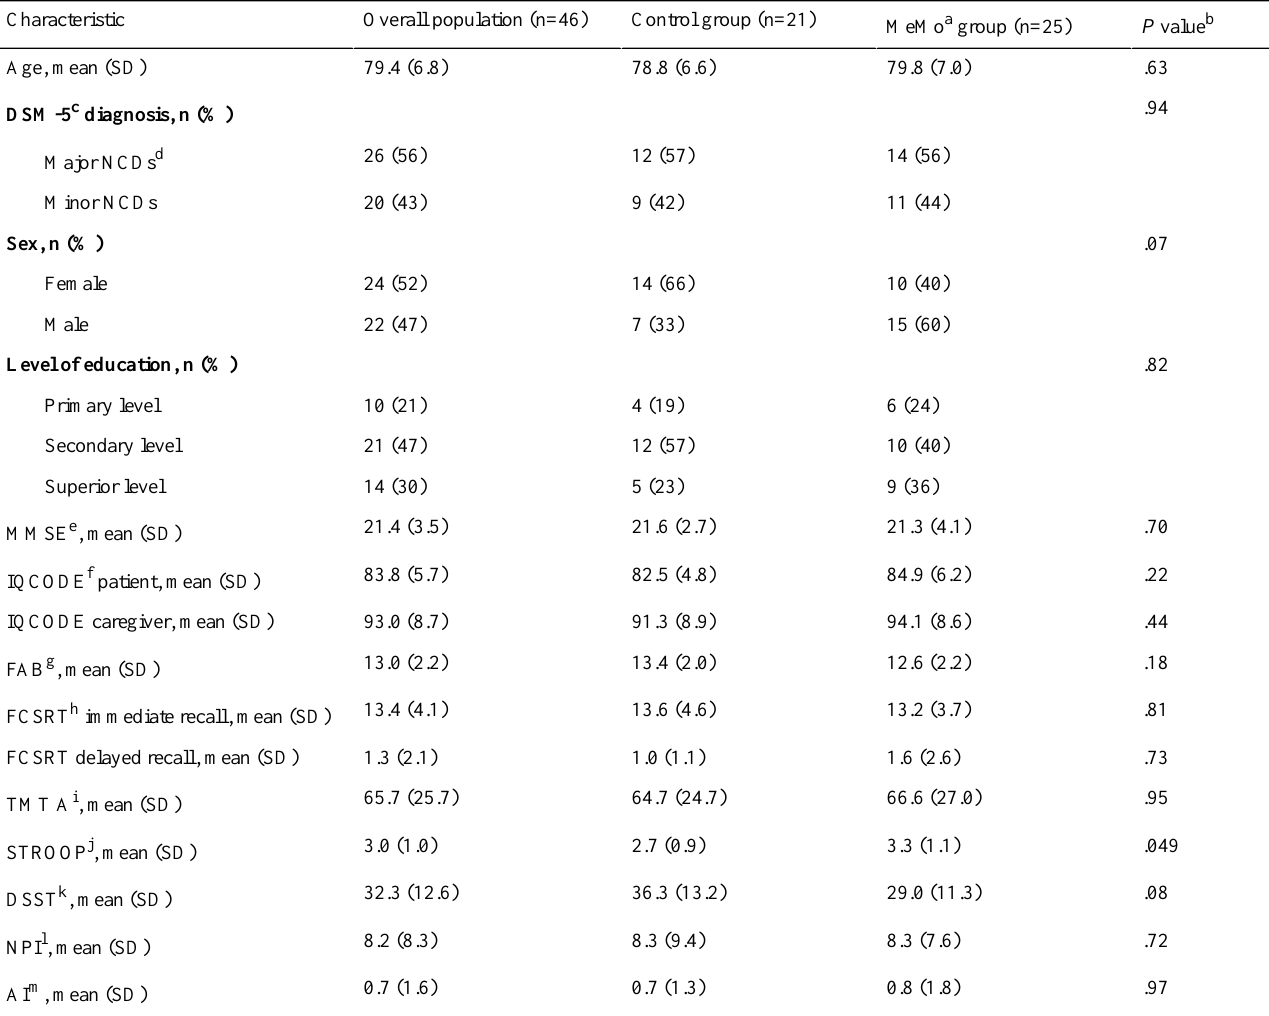
Table 1. Demographics and clinical characteristics of the study